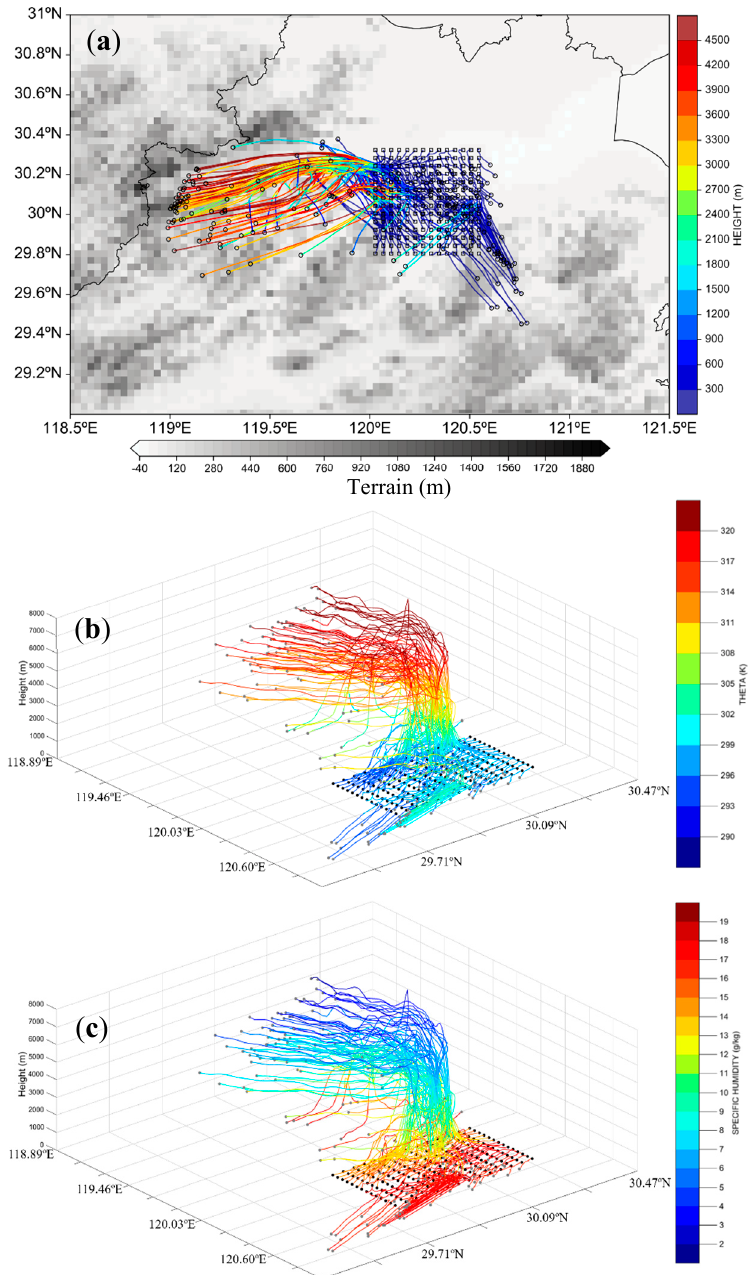
Figure 14. Panel ( a ) illustrates the trajectories of 196 points (small blue boxes) within the key region, where the shading is their height (m), small black circles show their starting locations, and the gray shading are the terrain (m). Panel ( b ) is the 3D illustration of the trajectories of 196 points (small black dots) within the key region, where the shading is their potential temperature (K) and gray points are their starting locations. Panel ( c ) is the same as ( b ) but for the specific humidity (g kg − 1